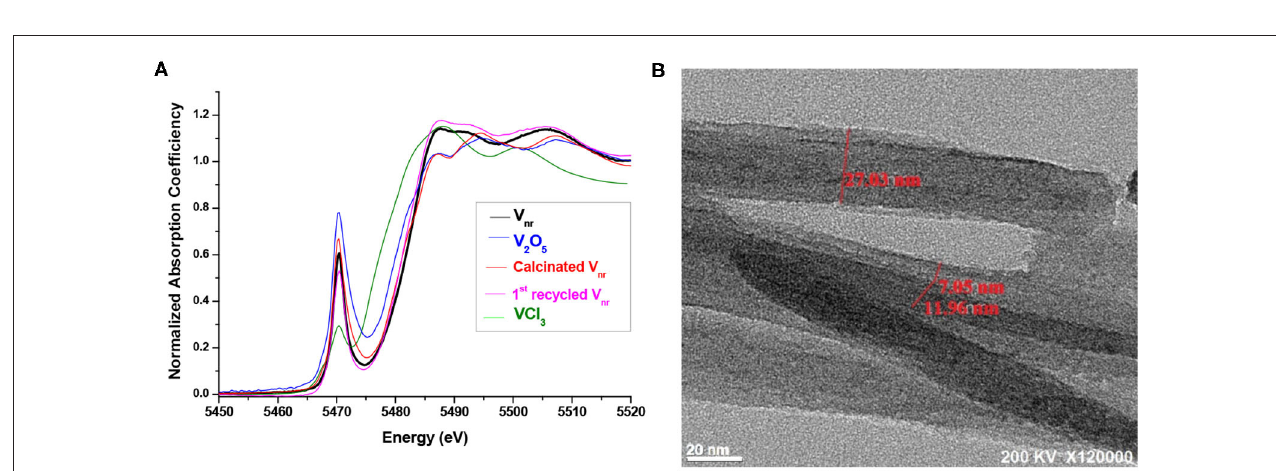
FIGURE 4 | (A) Normalized V K-edge X-ray absorption near edge structures (XANES) of vanadium oxide nanorod ( V nr ) ( black line ) and its calcined materials ( V nr (cal) , red line ), V 2 O 5 ( blue line ), VCl 3(aq) ( green line ), and the 1 st recycled V nr ( magenta line ) recycled from the V nr catalyst after the catalytic reaction of benzene. (B) The high-resolution TEM image of rod-shaped V nr . Reproduced with permission from Wanna et al. (2019a). Copyright 2019 The Royal Society of Chemistry.